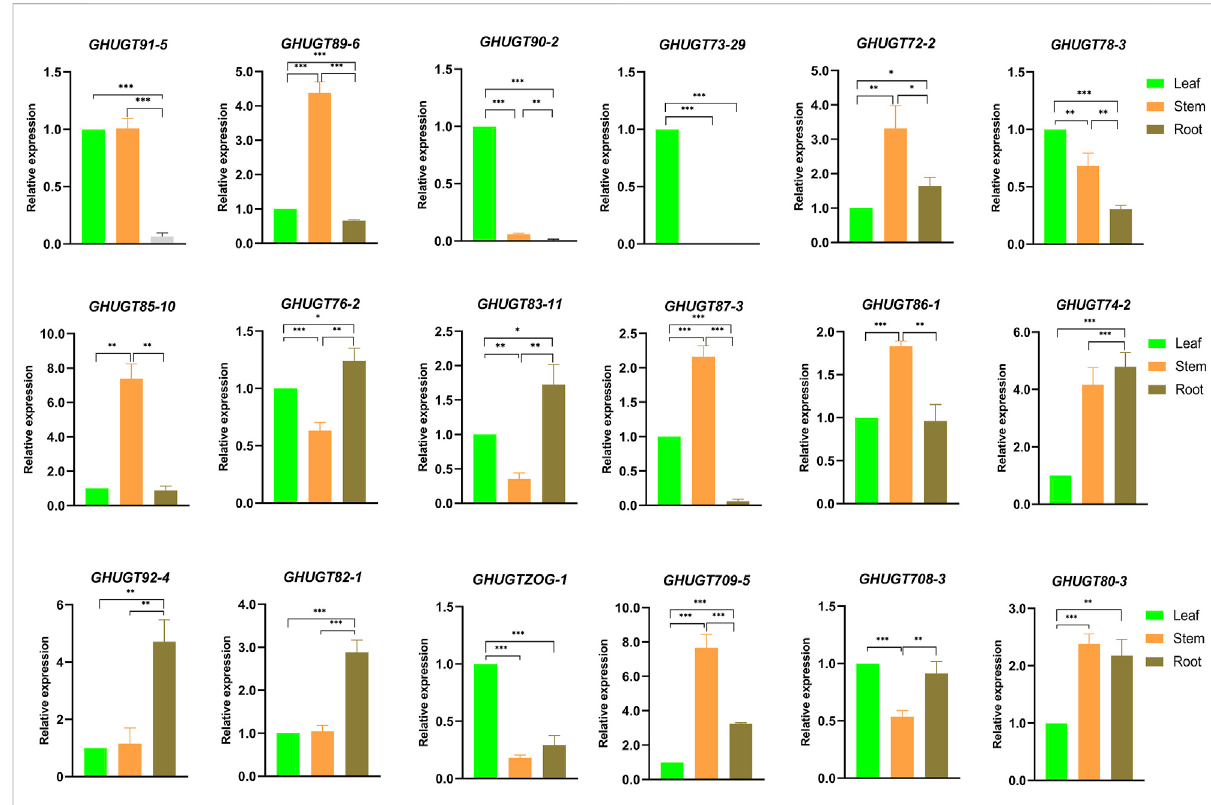
FIGURE 11 Tissue-speci fi c expression of 18 GHUGT members differentially expressed genes. *: p < 0.05, **: p < 0.01 and ***: p < 0.001. Error bars are the standard deviation (SD) of three biological replicates in each treatment group. The statistical test is Student ’ s t-test.